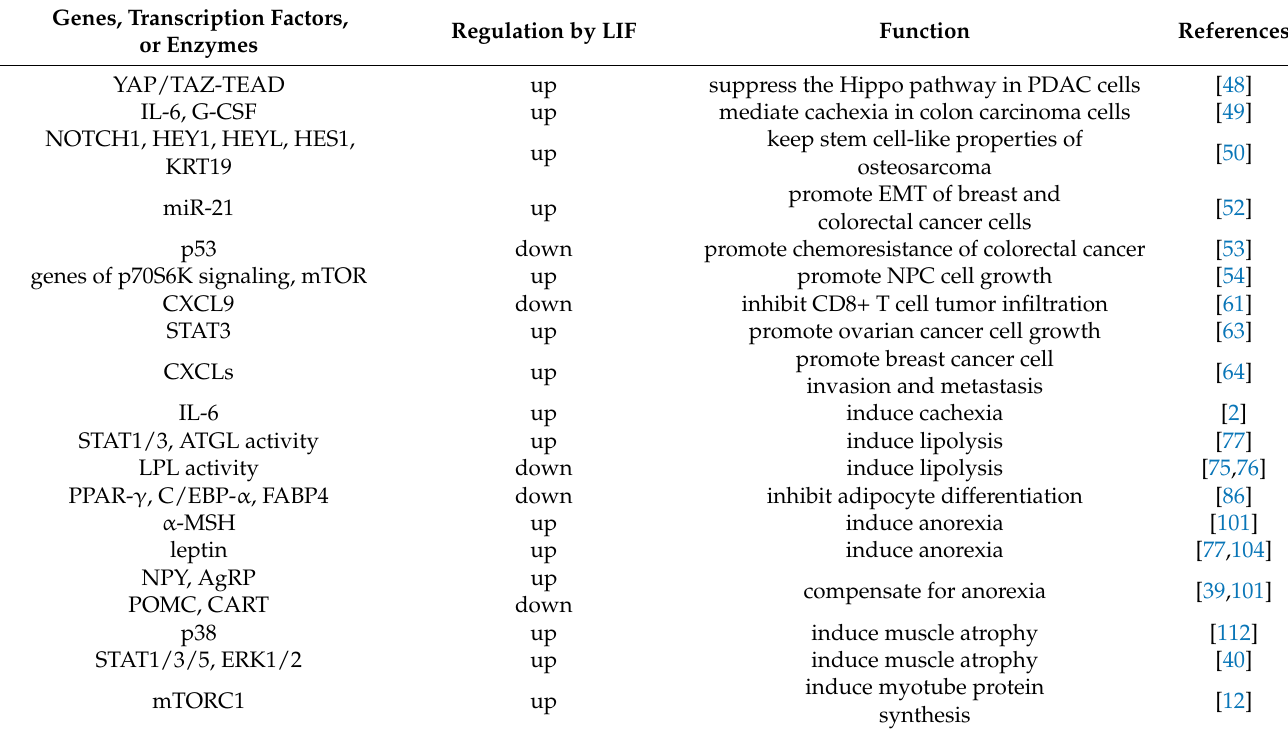
Table 2. Genes, transcription factors, or enzymes regulated by